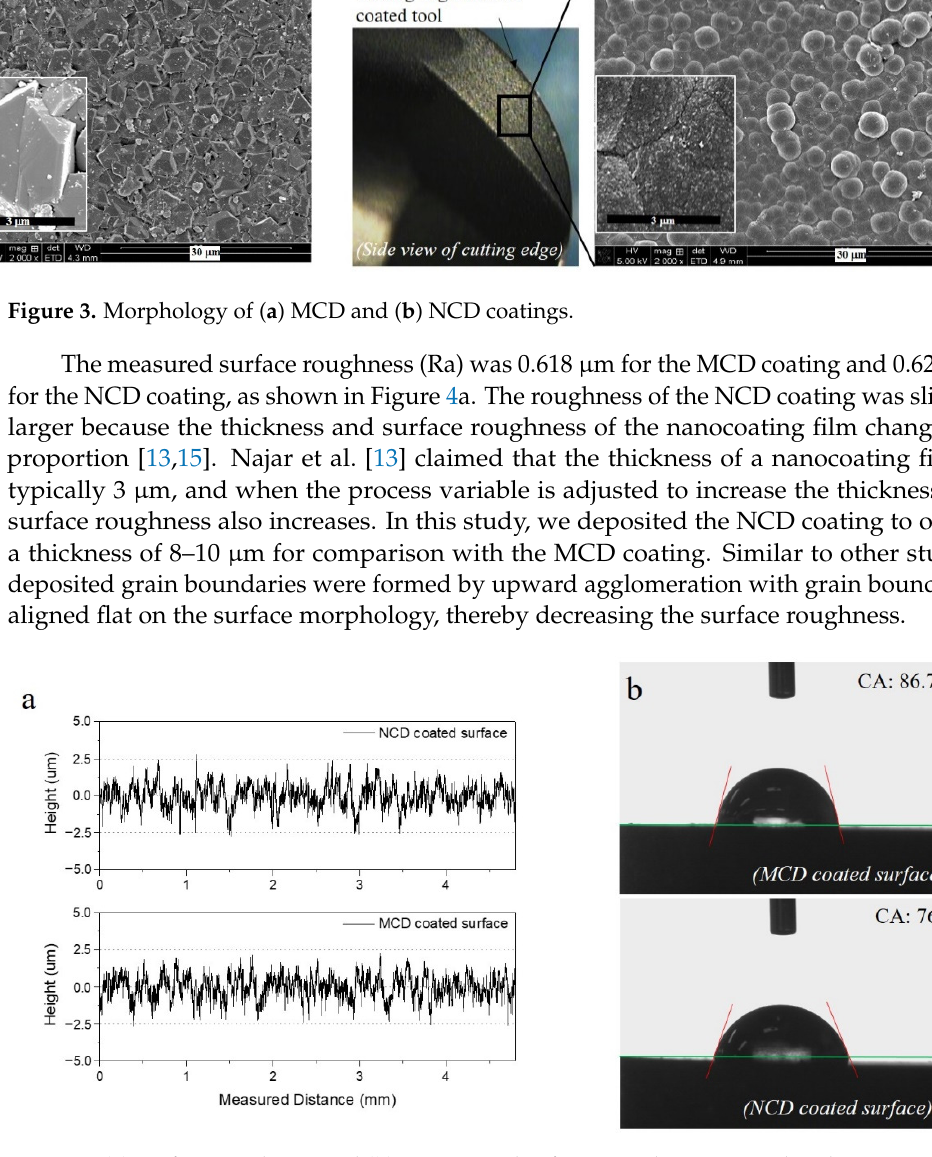
Figure 4. ( a ) Surface roughness and ( b ) contact angle of MCD and NCD-coated tools.